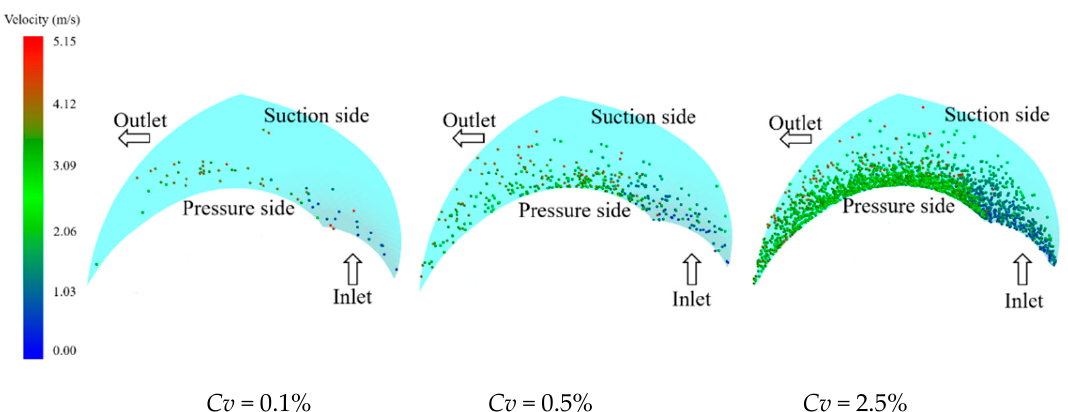
Figure 12. Particle distribution in one flow passage of the pump impeller under different particle volume fractions.